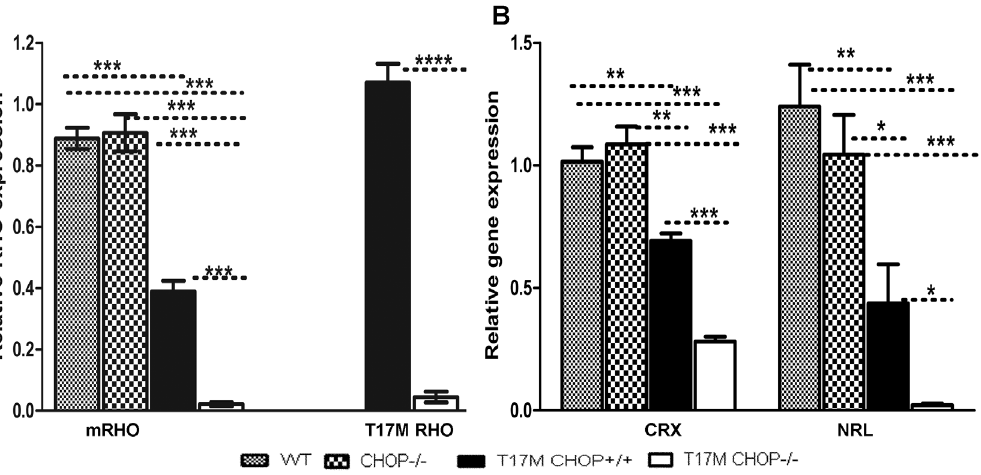
Figure 3. CHOP ablation in P30 T17M RHO retinas modulates the expression of Rhodopsin (m-Rho and h-Rho) and photoreceptor- specific transcription factor (Crx and Nrl) genes. We analyzed 4 groups of animals (N=6) and found differences in the expression levels of Crx , Nrl and RHO (mRho and T17M RHO ). A: mRho and T17M RHO expression was modulated in T17M RHO CHOP 2 / 2 retinas. The relative expression of endogenous mouse Rho was 0.9 6 0.03 in wild-type; 0.9 6 0.06 in CHOP 2 / 2 ; 0.4 6 0.03 in T17M RHO ; and 0.02 6 0.01 in T17M RHO CHOP 2 / 2 mice. The differences between wild-type and T17M RHO or T17M RHO CHOP 2 / 2 and CHOP 2 / 2 and T17M RHO or T17M RHO CHOP 2 / 2 were statistically significant ( P , 0.001). The 96% reduction of endogenous RHO gene expression, observed in T17M RHO CHOP 2 / 2 mice compared to T17M RHO mice was statistically significant ( P , 0.001). No difference in Crx gene expression was observed when the expression of mRho mRNA was compared in wild- type and CHOP retinas. The expression of the human T17M RHO transgene was also modulated in T17M RHO CHOP 2 / 2 mice, with a value of 1.1 6 0.06 in T17M RHO mice vs. 0.04 6 0.01 in T17M RHO CHOP 2 / 2 mice. The observed 96% reduction of transgene expression was statistically significant ( P , 0.0001). B: Modified Expressions of Crx and Nrl in the T17M RHO CHOP 2 / 2 retina. The relative Crx gene expression was 1.0 6 0.059 in wild-type; 1.1 6 0.1 in CHOP 2 / 2 ; 0.7 6 0.03 in T17M RHO; and 0.3 6 0.02 in T17M RHO . The differences between the wild-type or CHOP 2 / 2 and T17M RHO groups were statistically significant ( P , 0.01), as were the differences between wild-type or CHOP 2 / 2 and T17M RHO CHOP 2 / 2 ( P , 0.001).